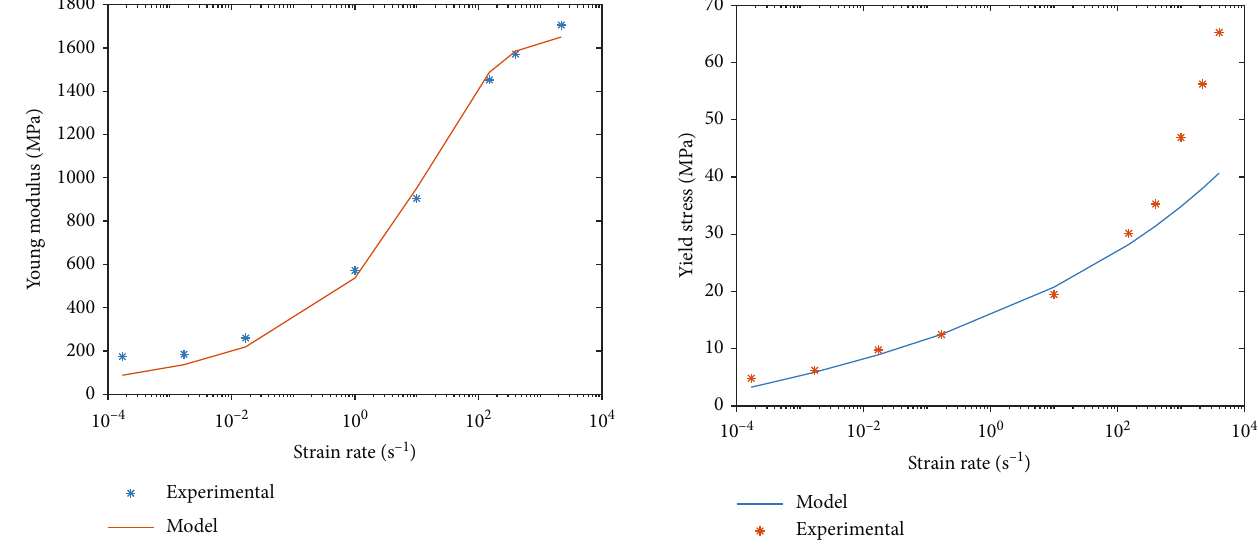
Figure 10: Young ’ s modulus prediction. Figure 11: Yield stress